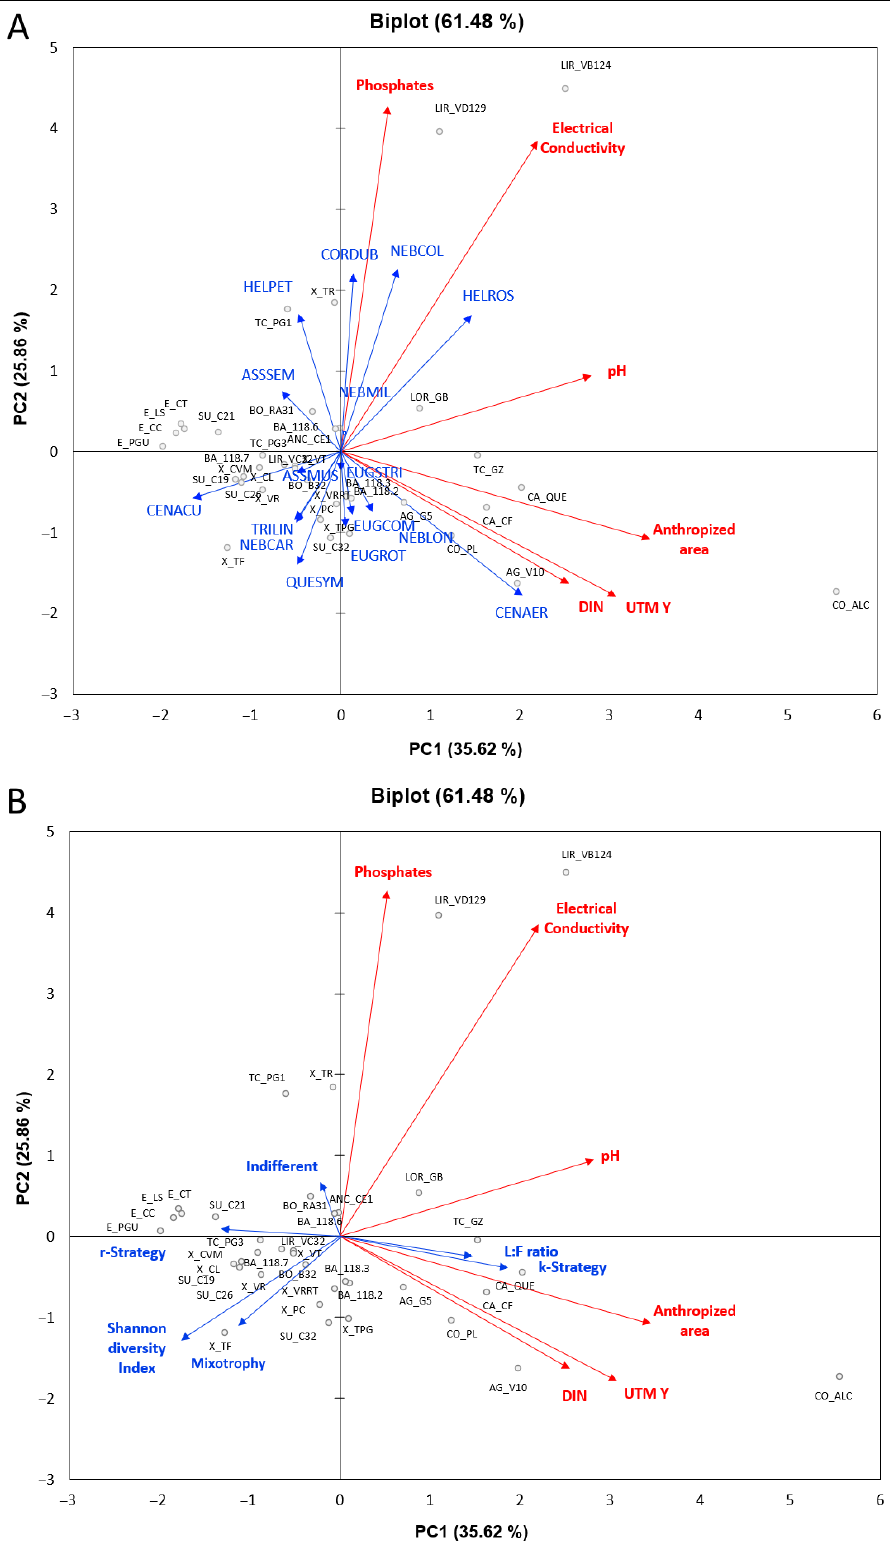
Figure 3. Biplots of the Redundancy Analysis (RDA) performed on the dataset of environmental parameters and testate amoeba community structures in western Iberian peatlands, both based on ( A ) testate amoeba community structures and ( B ) testate amoeba functional groups (i.e., K-strategists, r-strategists, mixotrophic, indifferent, L:F ratio and Shannon diversity index).